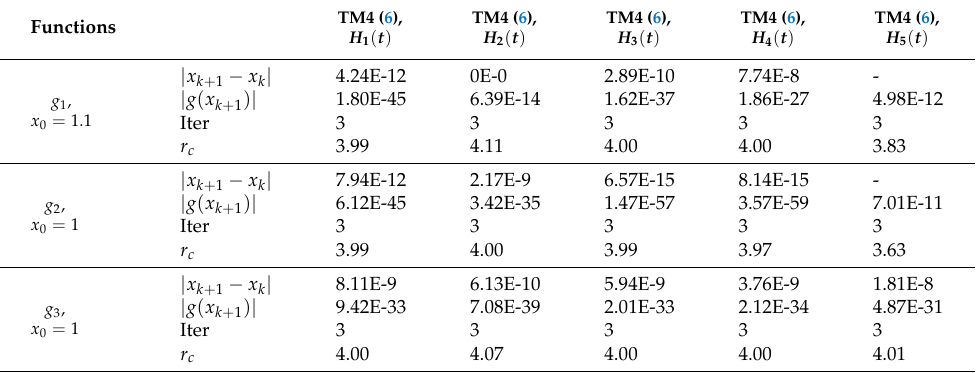
Table 2. Comparison of various iterative schemes (second part).